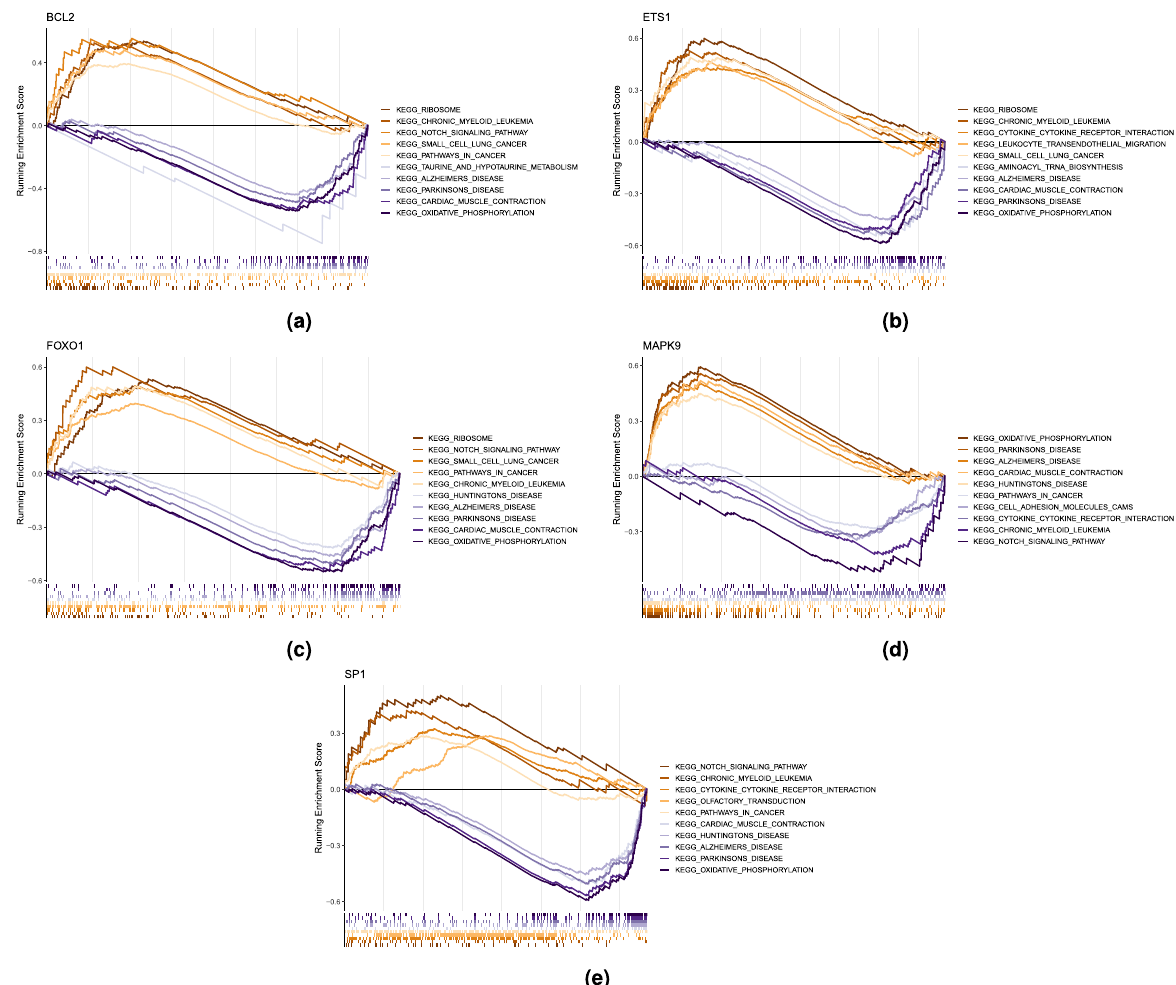
Figure 15. Gene set enrichment analysis for ( a ) BCL2, ( b ) ETS1, ( c ) FOXO1, ( d ) MAPK9, and ( e ) SP1.